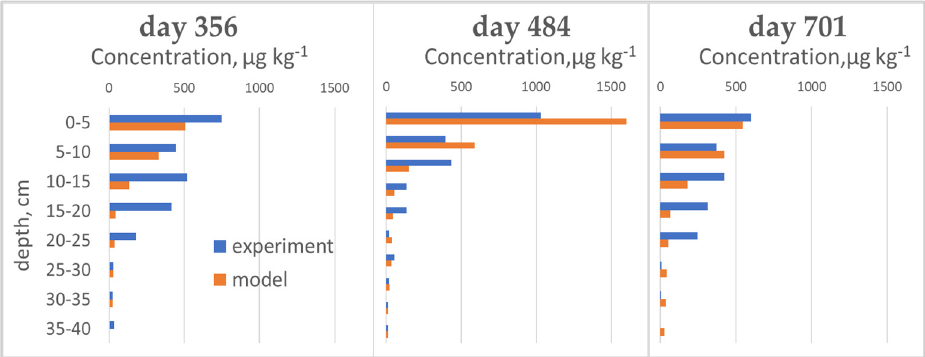
Figure 5. Measured and simulated cyantraniliprole distributions on different sampling days in the Figure 5. lysimeter.